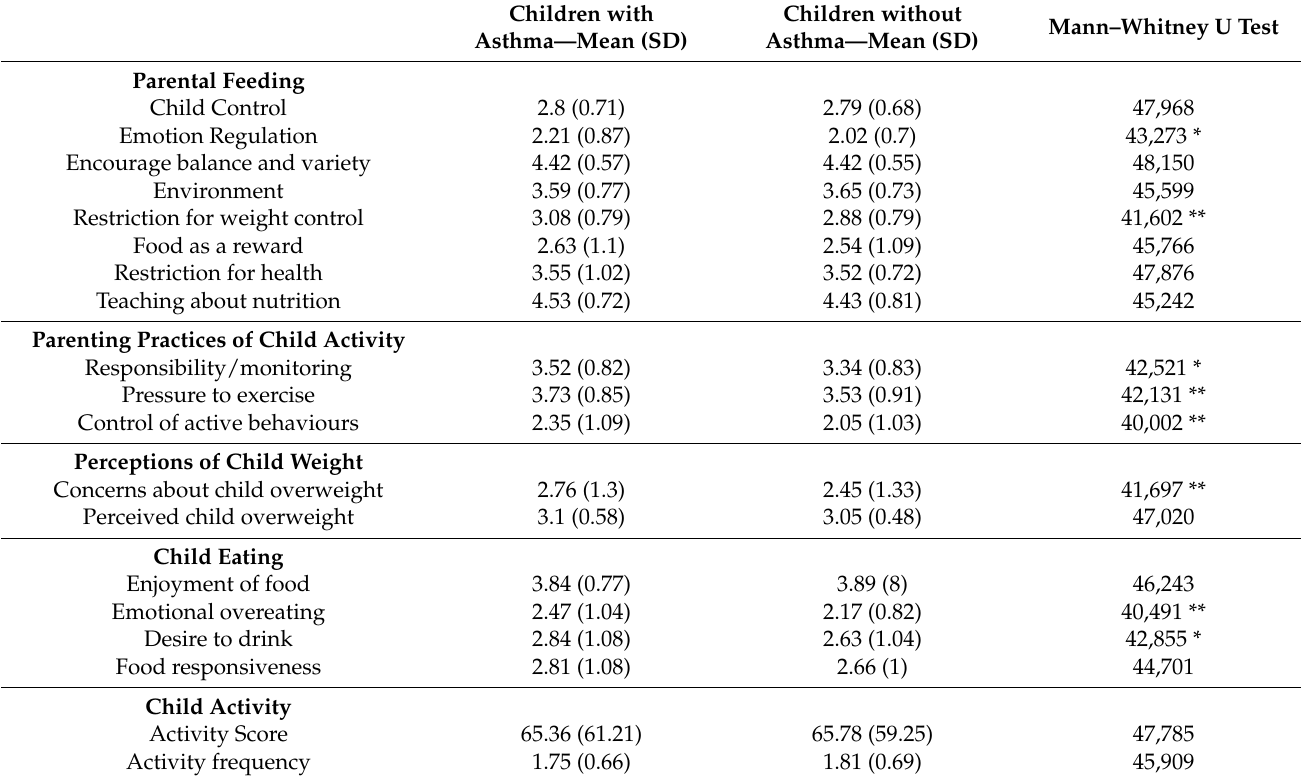
Table 3. Descriptive statistics and comparisons between groups of parents of children living with and without asthma on parental feeding, child eating and exercise variables and child